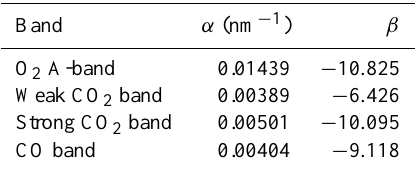
Table 1. Coefficients in the linear approximations to H(λ) and V (λ) . Wavelength λ is assumed in